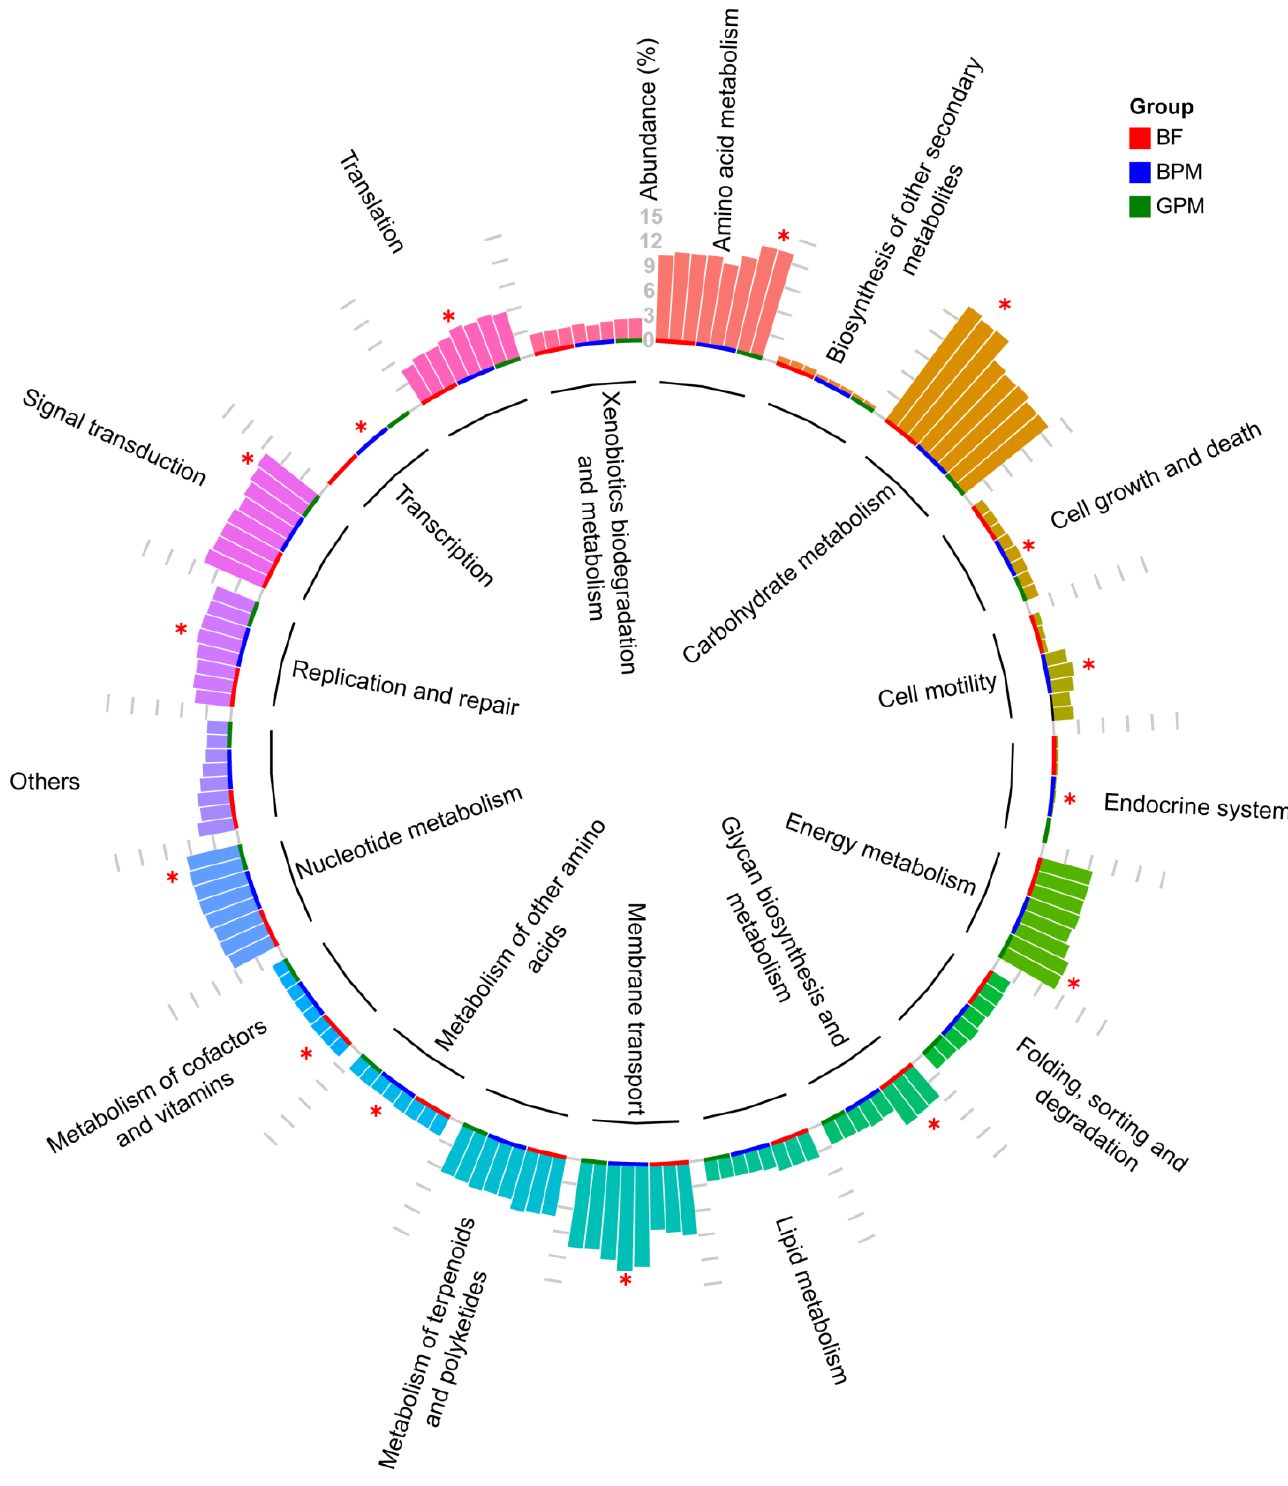
Figure 5. Predictive analysis of the gut microbial function in young elephants. * Metabolic pathways that were significantly different between groups ( p < 0.05).